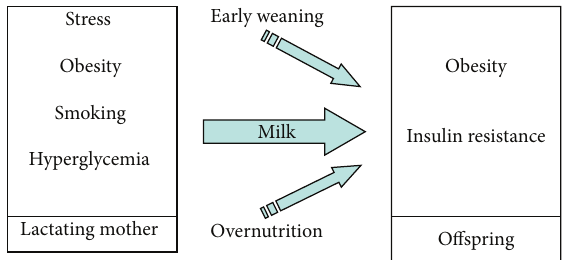
Figure 3: Lactation and insulin resistance. It has been found that both early weaning and overfeeding by more milk intake may lead to insulin resistance in later life. Maternal stress, obesity, hyperglycemia, and even smoking during lactation might also cause reduced insulin sensitivity in the offspring, which suggest that the breast milk can be the “agent,” transferring altered levels of hormones, insulin, or fatty acid contents from maternal circulation to